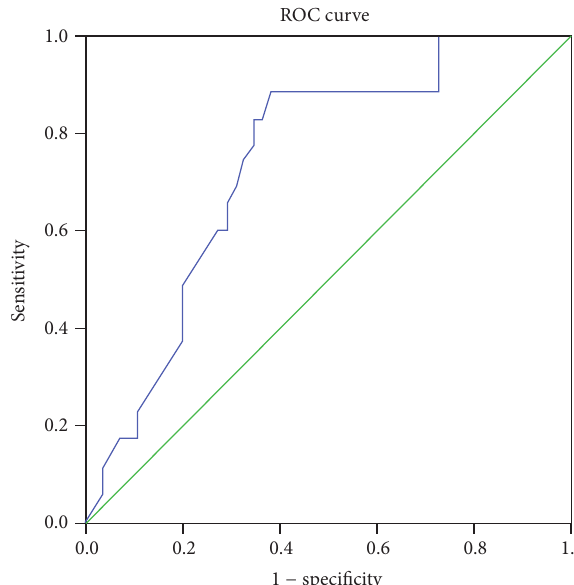
Figure 2: ROC curve was plotted to check the diagnostic signif- icance of VEGF in PIH. Area under the curve was found to be 73.8% ( 𝑝 < 0.0001 ), 95% confidence interval range was 63.5– 89%. At VEGF level 14.04 pg/mL, sensitivity was found to be 88.6% and specificity to be 61.8% (Youden’s index 𝐽 = 0.05 ). ROC plot demonstrates performance of serum VEGF to detect PIH. Diagonal segments are produced by